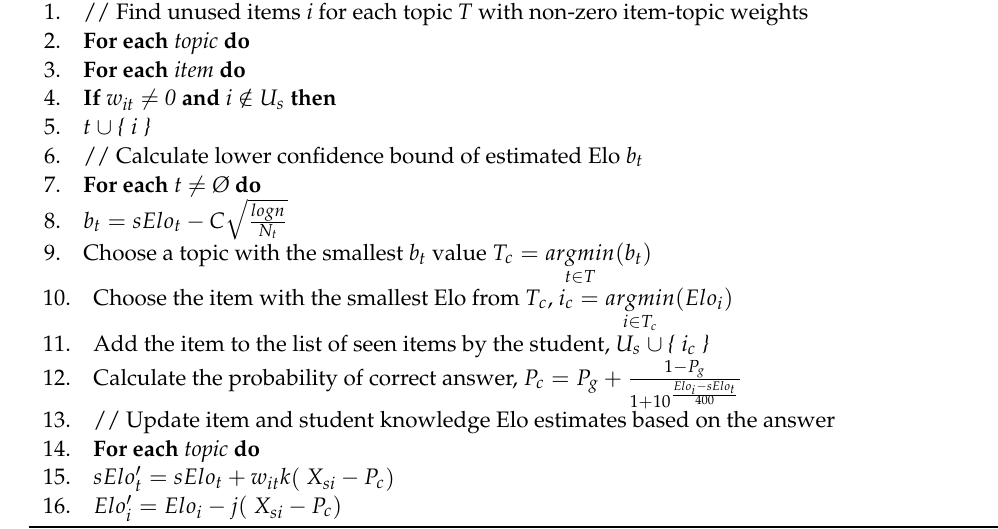
Algorithm 1. The proposed Elo-bandit algorithm for test item